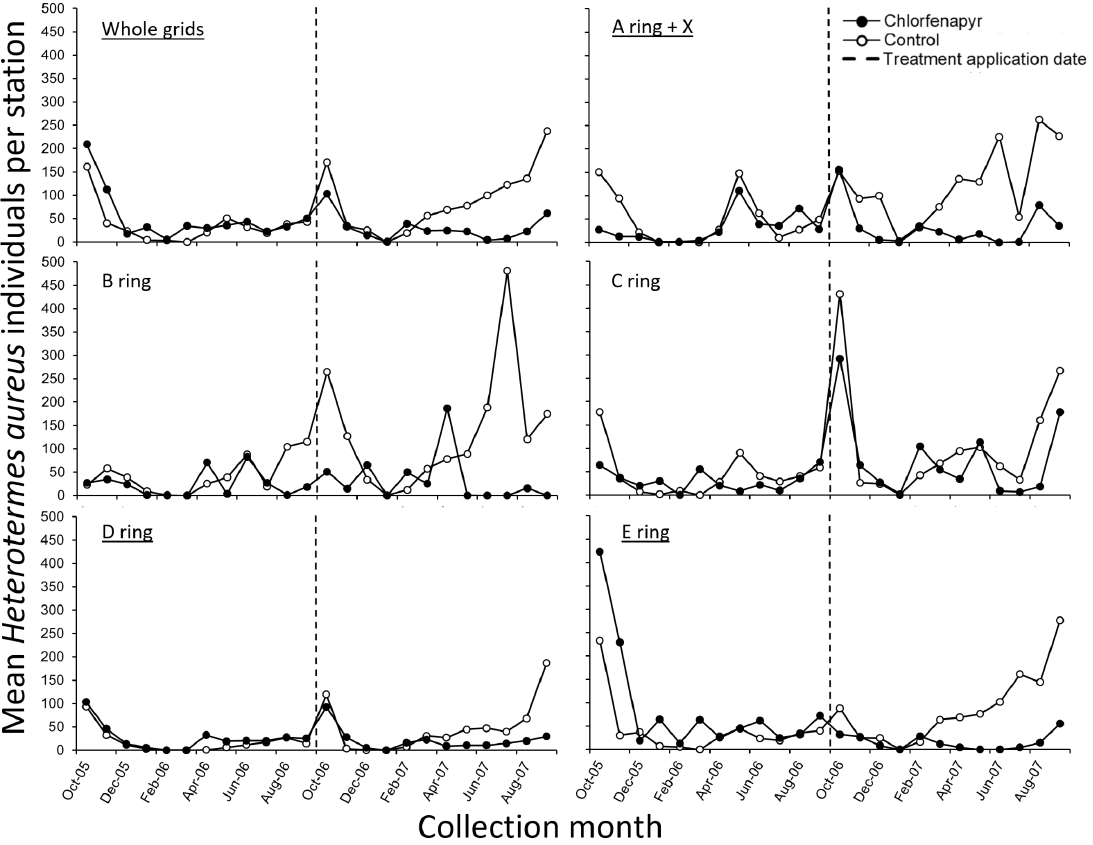
Fig 4 . Average number of desert subterranean termites collected per station per month in whole control and chlorfenapyr experimental grids and each of their sections (n = 3 for each treatment). Labels for every other collection month are included in the horizontal axes. The names of grid sections for which analysis showed a significant change in termite counts with respect to controls after treatment application are shown underlined.